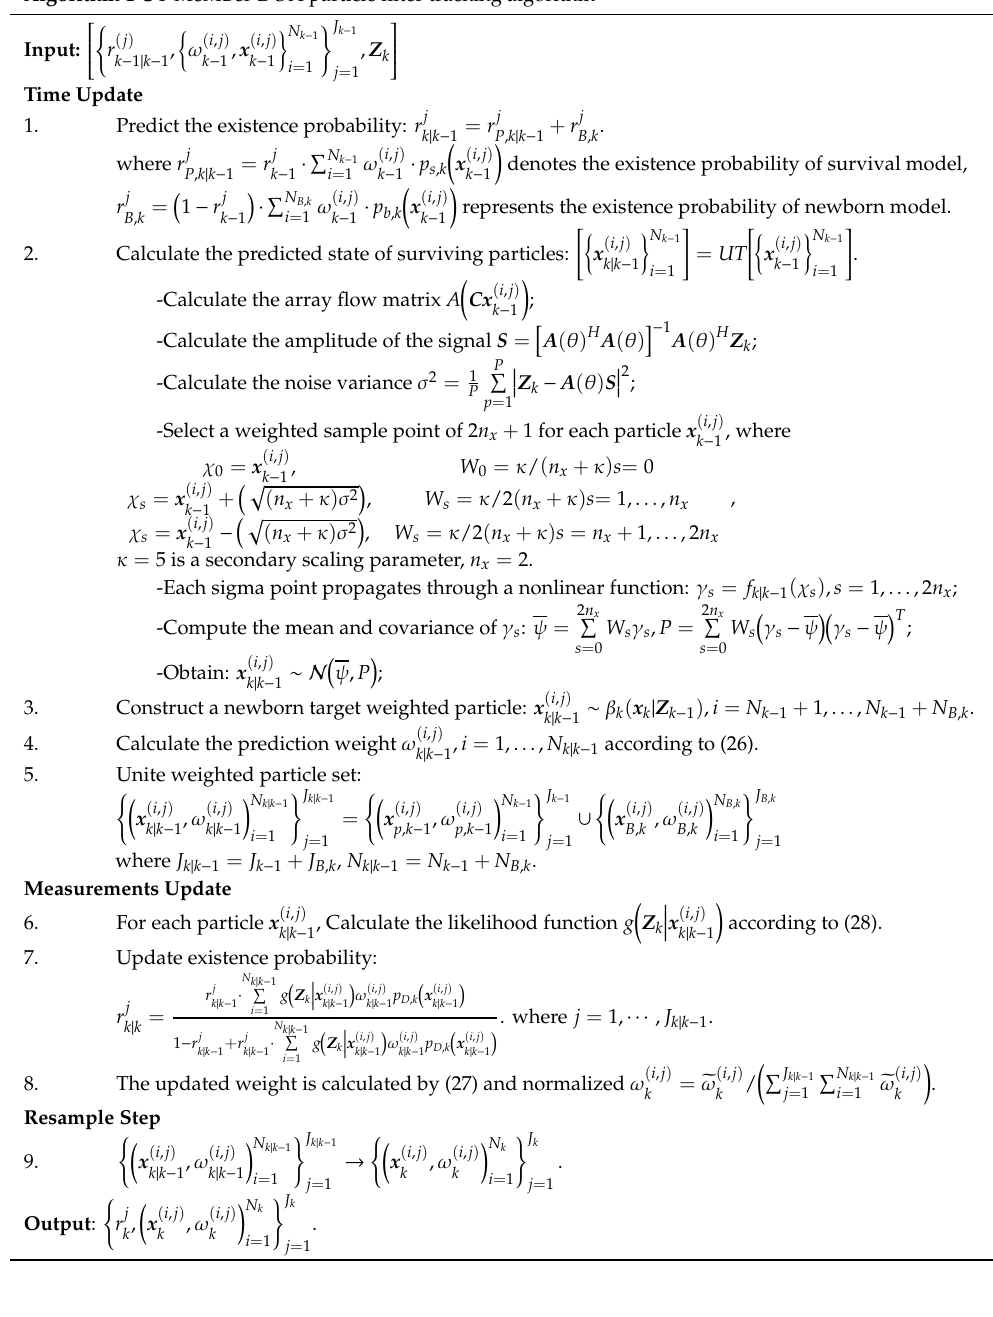
Algorithm 1 UT-MeMBer DOA particle filter tracking